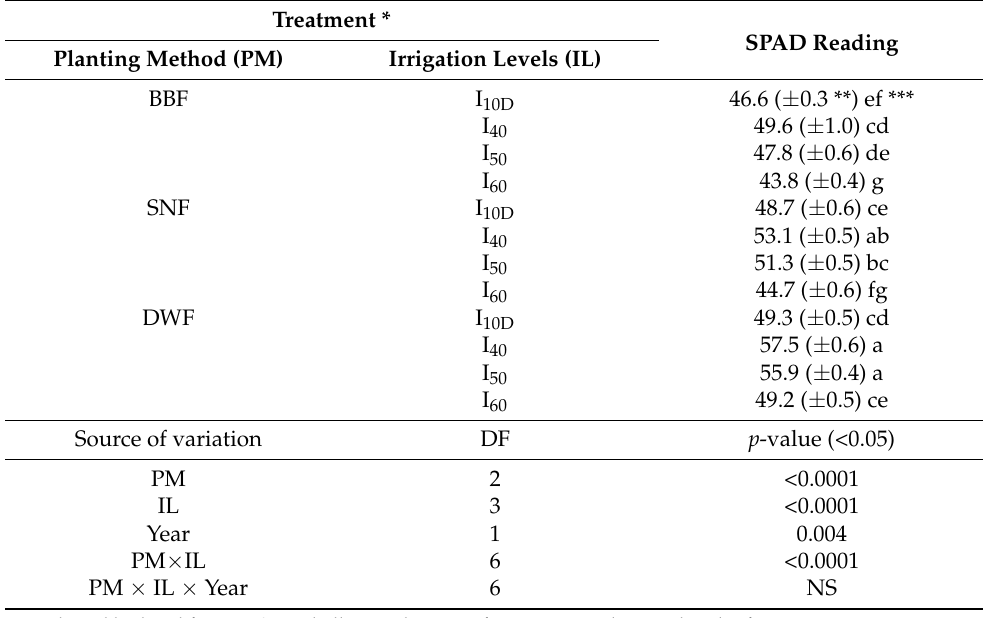
Table 2. Interaction of planting methods, irrigation levels, and year influenced SPAD reading of maize at 60 DAS in Dharwad,